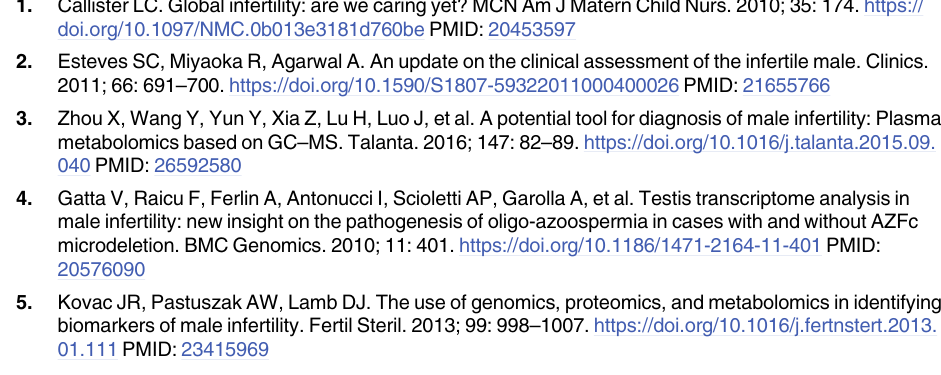
S1 File. Qualitative and quantitative table used for the PLS-DA model (after normaliza-